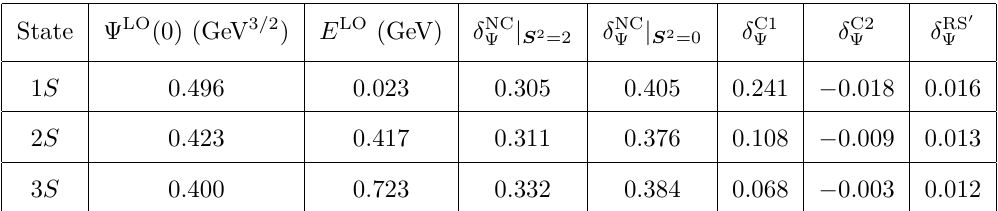
Table 2 . LO wavefunctions at the origin, LO binding energies and the relative corrections to the wavefunctions at the origin in the MS scheme at scale Λ = m for 1 S , 2 S , and 3 S bottomonium states. δ NC